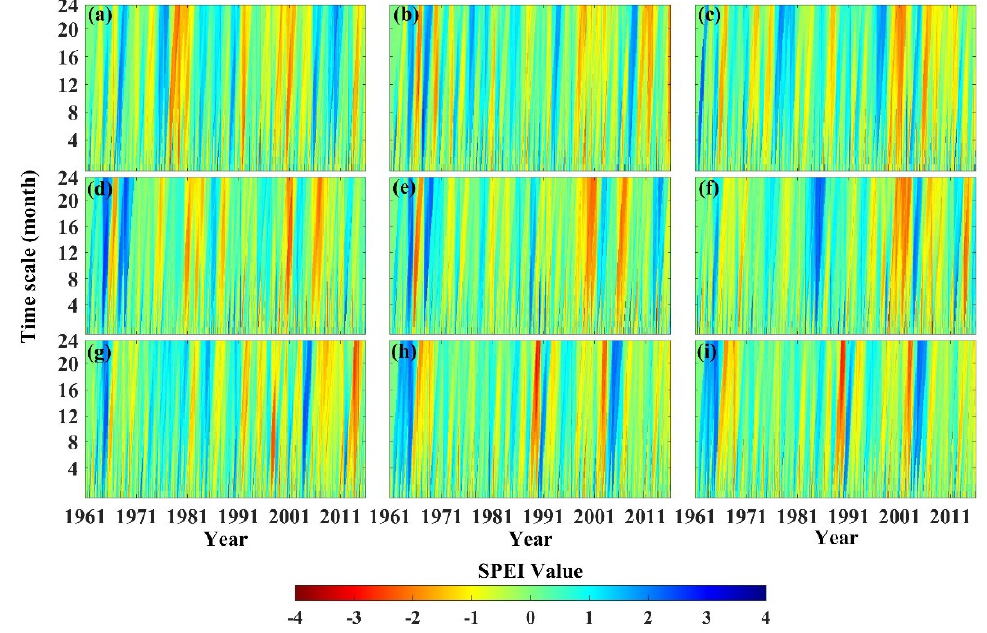
Figure 3. Hovmoller-type diagrams for the temporal variability of drought at different timescales (1 to 24 months) in the YRB. ( a )–( i ) denote above AL, LL, LH, IF, HL, LS, SH, BH, and YRB.